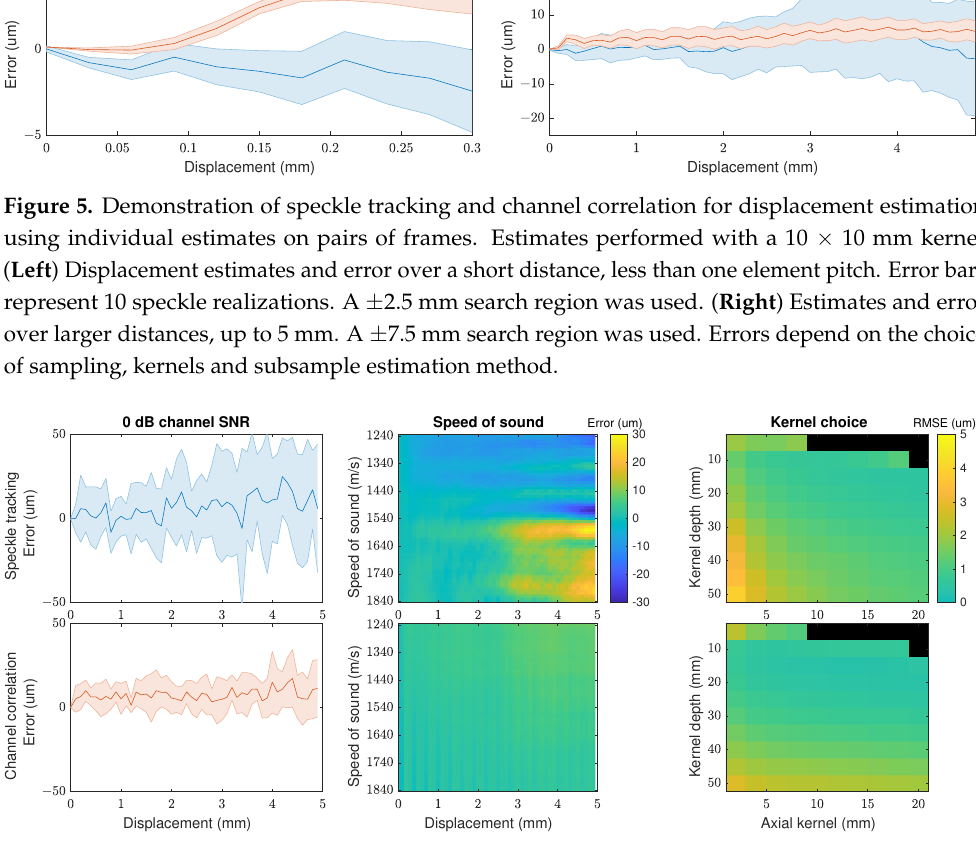
Figure 6. Challenges to and optimization of estimates in simulation. ( Left ) Additive channel noise reduces accuracy compared to Figure 5. ( Middle ) Errors in assumed speed of sound affects speckle tracking accuracy but not channel correlation (true speed of sound 1540 m/s). ( Right ) Speckle tracking is more sensitive than channel correlation to choice of kernel location and depth. (Black indicates regions where the chosen kernel extended beyond the data/image